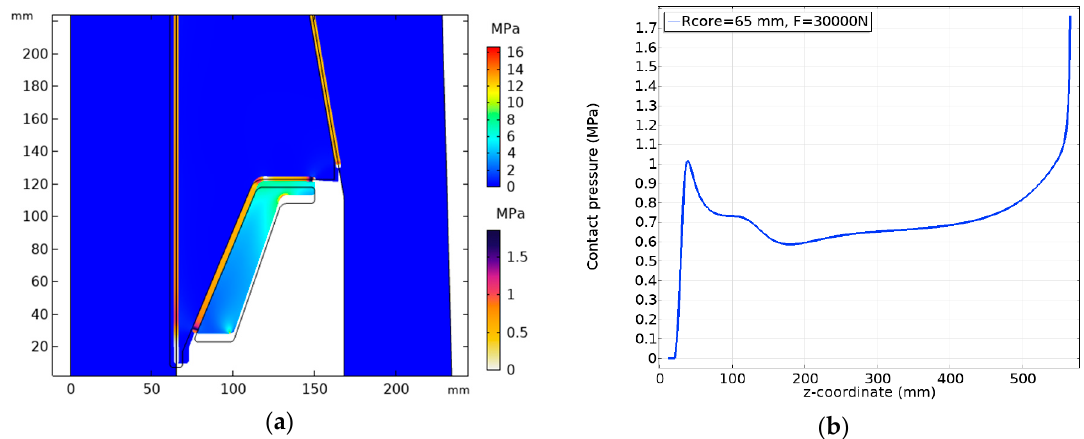
Figure 8. The von Mises stress and the contact pressure are shown in ( a ). The upper color legend is for the von Mises, and the lower one is for the contact pressure. The contact pressure between the stress cone and cable insulation is shown in ( b ). The outer radius of the cable insulation is 65 mm, and the total force of the spring is 30 kN.